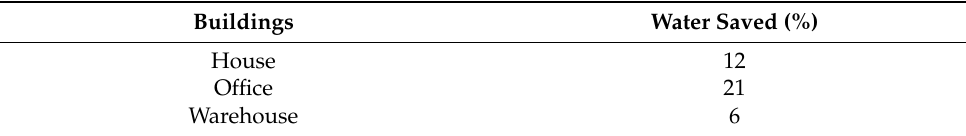
Table 10. Water savings for the tested buildings.